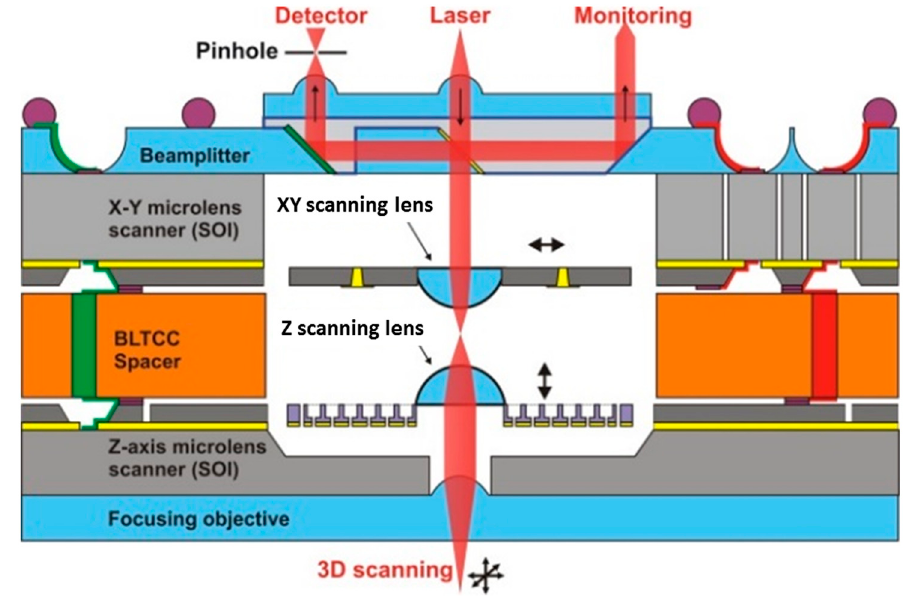
Figure 1. Schematic of the three-dimensional (3D) microscanner for on-chip scanning confocal microscope. Reproduced with permission from [9], published by SPIE, 2013.